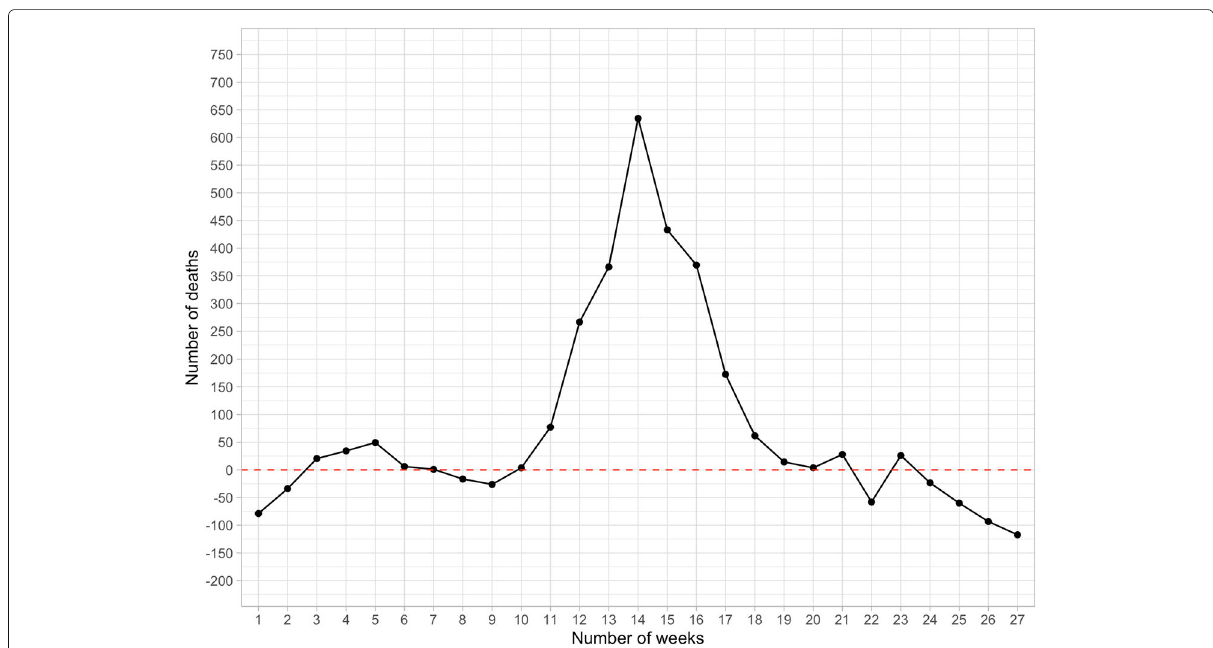
Fig. 5 Excess mortality 2020 vs. mean 2000–2019. Note: This figure plots the weekly difference between the death counts in 2020 and the corresponding mean computed over the years between 2000 and 2019. During the first 10 weeks of 2020, excess mortality is approximately zero in expectation, while during the phase of the pandemic outbreak (weeks 11–19), excess mortality becomes significantly positive